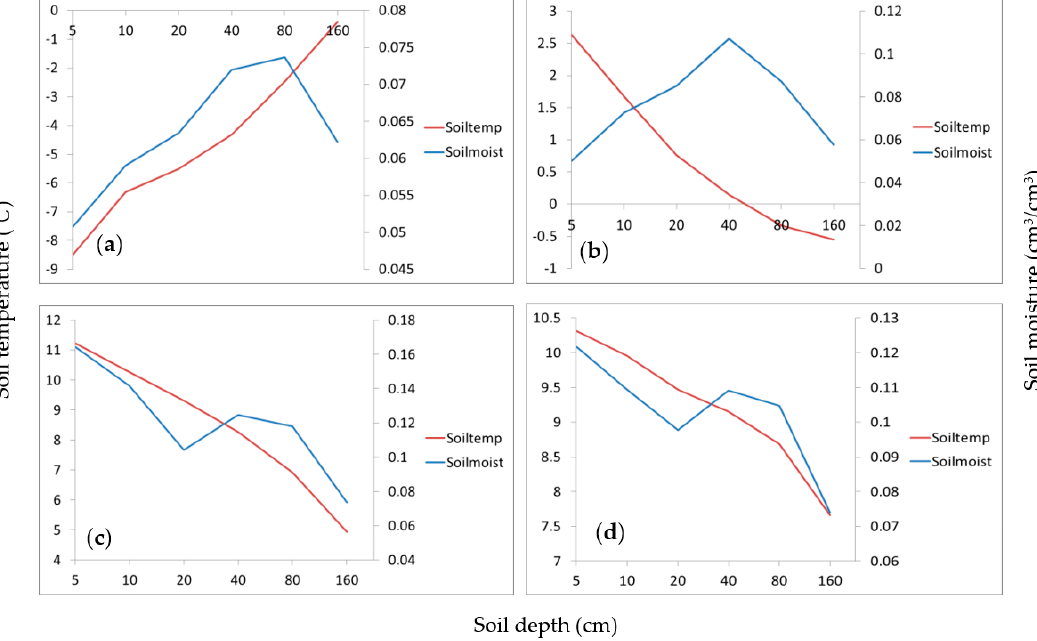
Figure 9. Profiles of soil temperature (red line) and soil moisture (blue line) at Amdo Station, ( a ) winter (December–February), ( b ) spring (March–May), ( c ) summer (June–August) and ( d ) autumn (September).